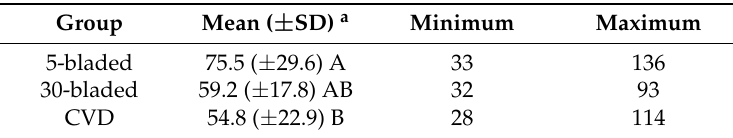
Table 4. Time required (in seconds) to remove adhesive